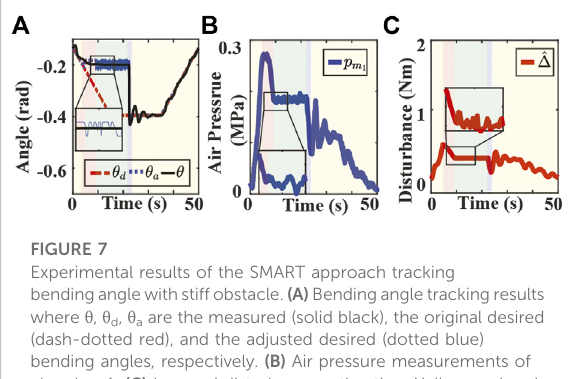
FIGURE 7 Experimental results of the SMART approach tracking bendinganglewithstiffobstacle. (A) Bendingangletrackingresults where θ , θ d , θ a are the measured (solid black), the original desired (dash-dotted red), and the adjusted desired (dotted blue) bending angles, respectively. (B) Air pressure measurements of chamber 1. (C) Lumped disturbance estimation. Yellow, red and blue indicate the tracking, compliance, and recovery modes. Green indicates the autonomous switching between the compliance and recovery modes.